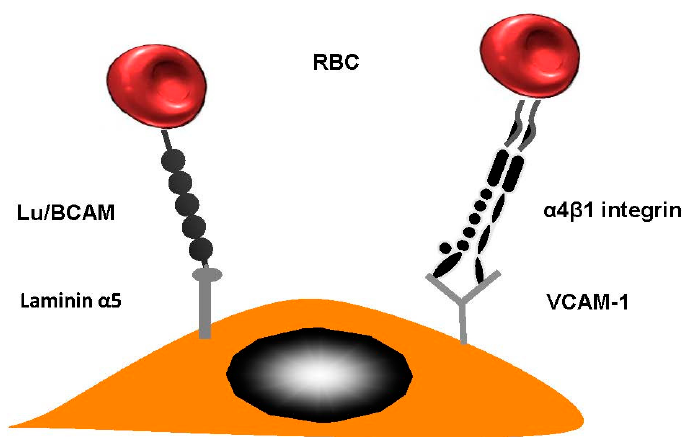
Figure 2. Red blood cell (RBC) adhesion in sickle cell diseases. Lutheran Lu / BCAM contains a particular protein which is able to forge a connection with laminin α 5. The latter occurs in the sub-endothelium; however, it can also occur on the apical side endothelial cell. VLA-4 ( α 4 β 1 integrin) is a molecule produced by reticulocytes; this had a strong sticky quality.